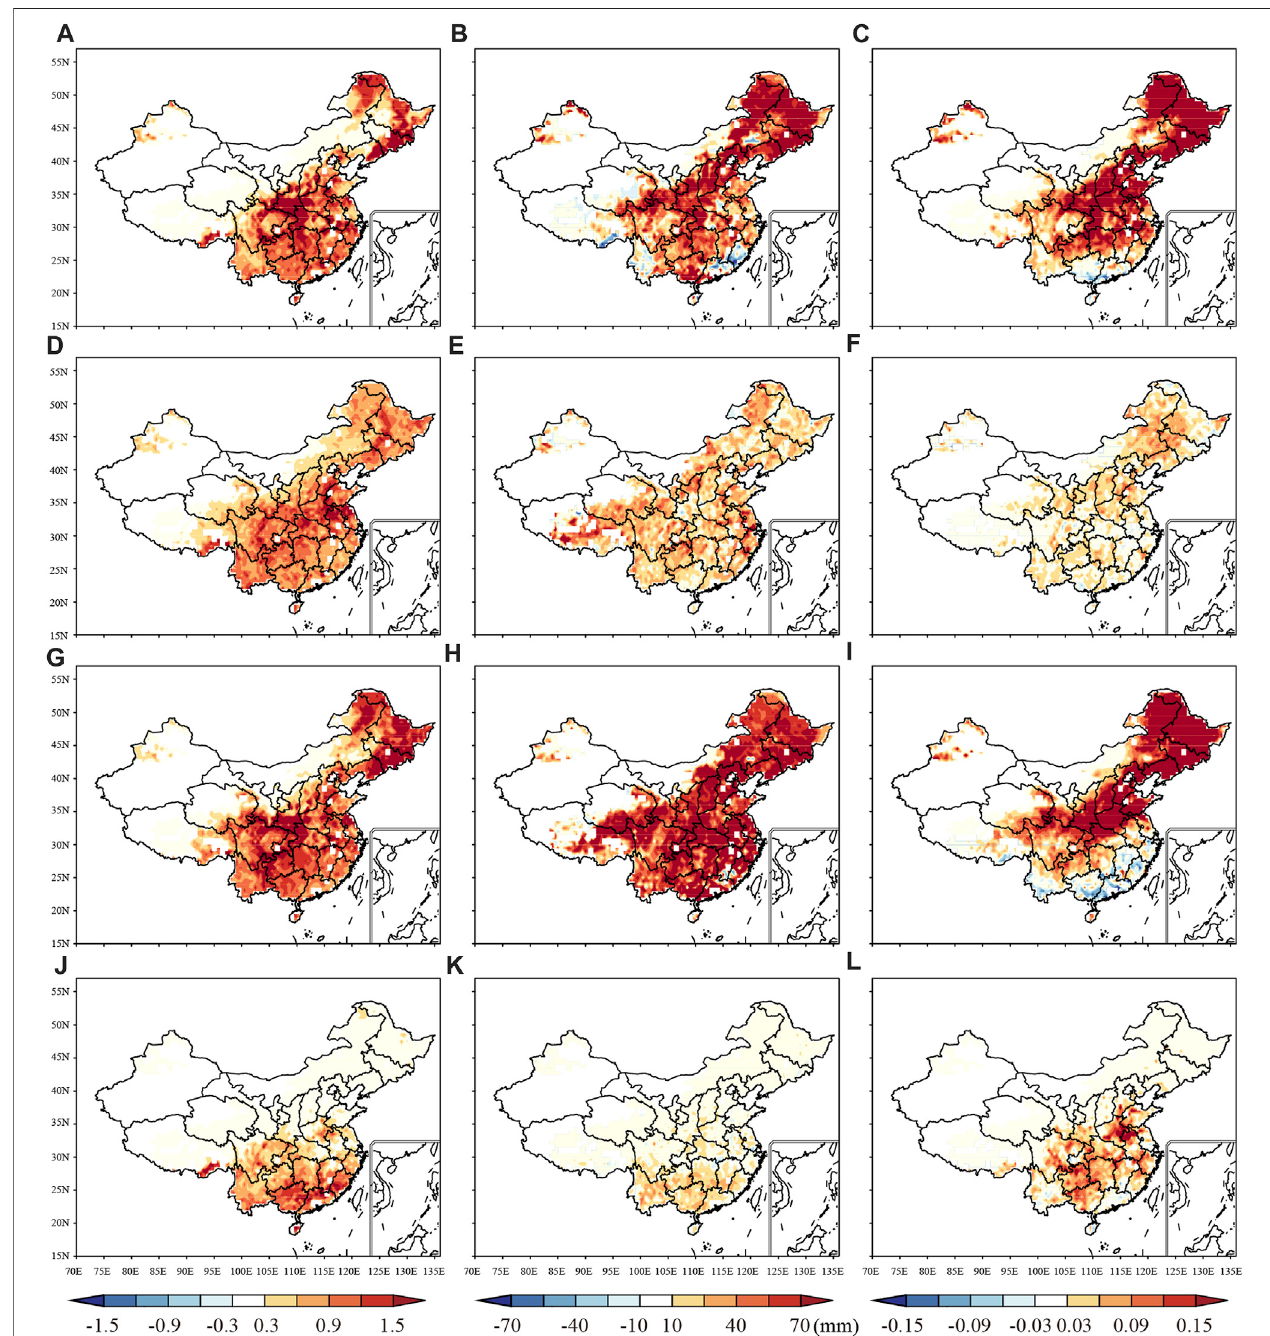
FIGURE 5 | Spatial distribution of positive anomalies in LAI, ET, and T/ET. The fi rst column is LAI, the second is ET, and the third is T/ET. Spring (A – C) summer (D – F) autumn (G – I) and winter (J – L) .